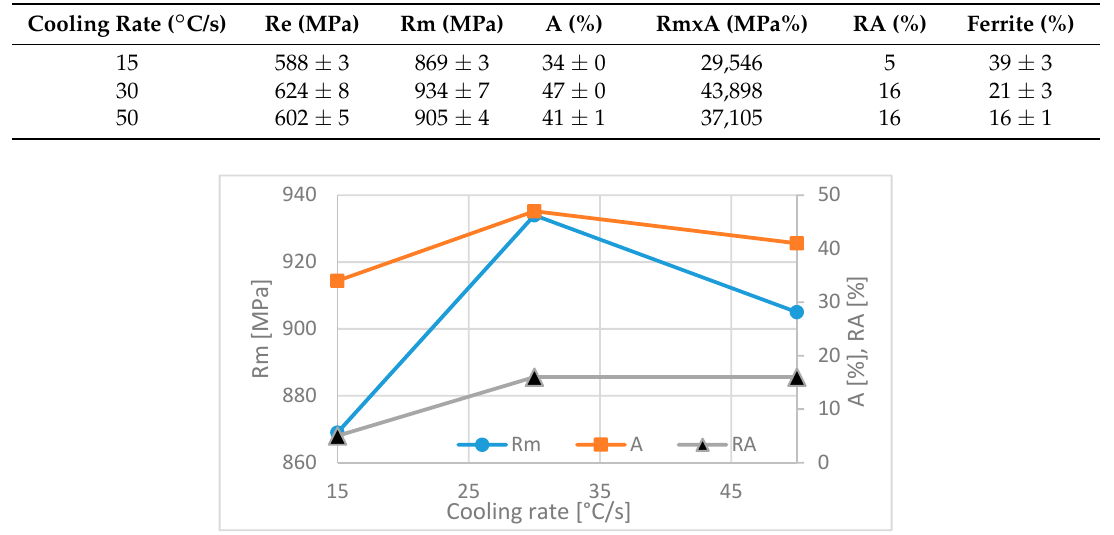
Table 3. Effect of cooling rate on tensile strength, total elongation, formability factor, retained austenite volume fraction, and polygonal ferrite fraction. Samples soaked at 850 °C/100 s with bainitic hold 400 °C/600 s.